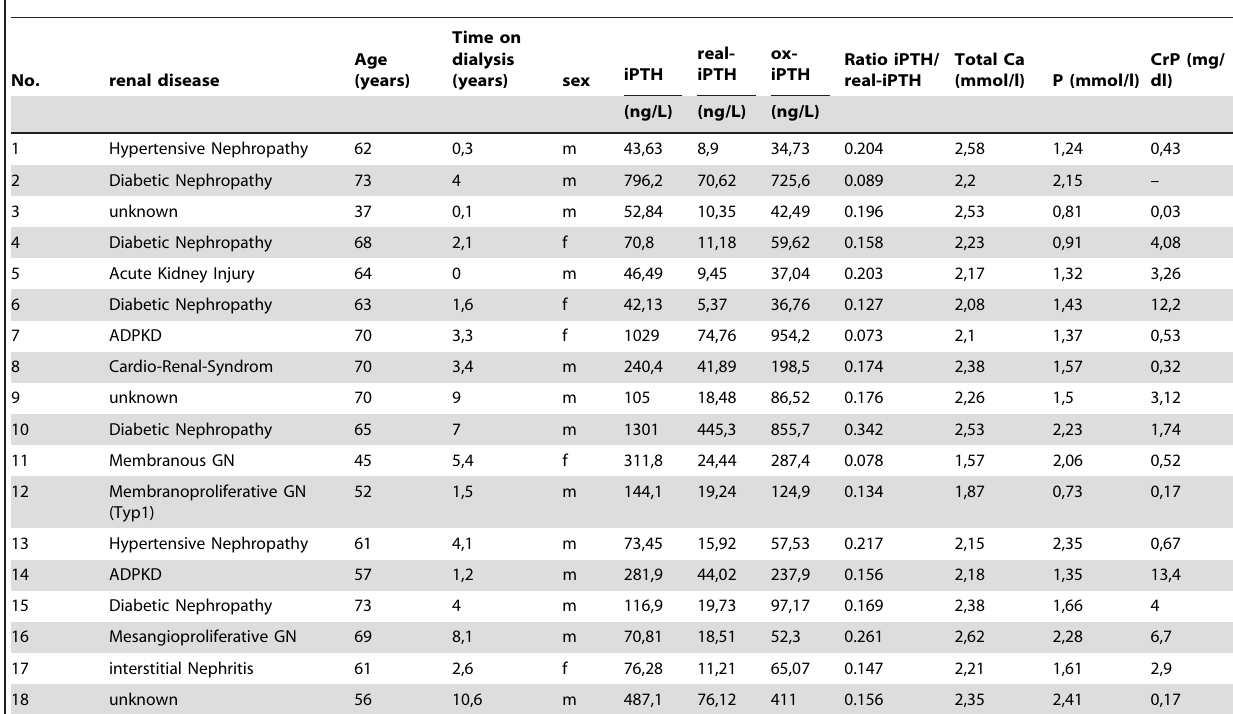
Table 2. Clinical Characteristic of the patients on dialysis.